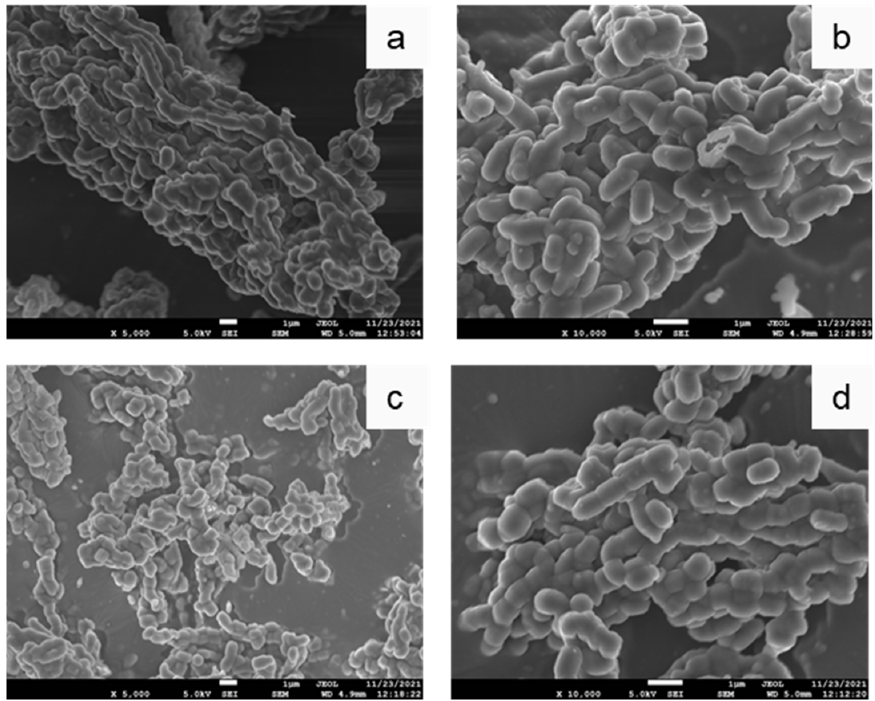
Figure 1. SEM images of the synthesized mesoporous silicas. ( a , b ) SBA ‐ 15 (8), and ( c , d ) SBA ‐ 15 (4).